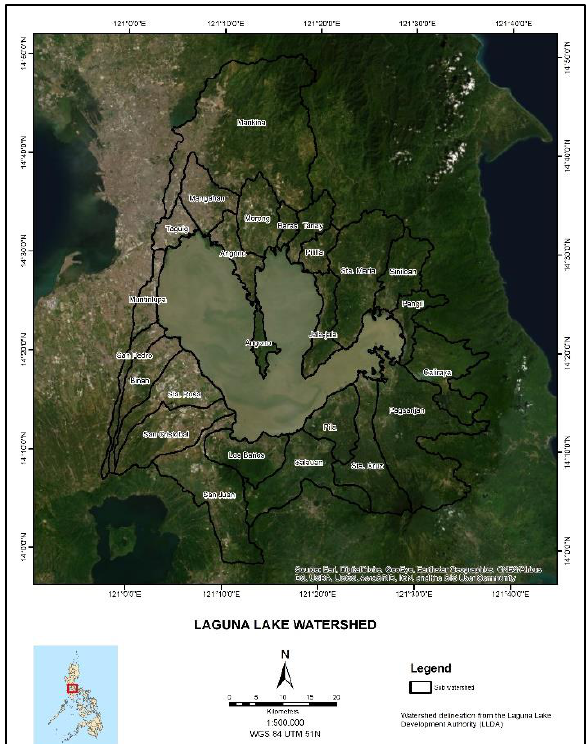
Figure 1. Laguna Lake watershed